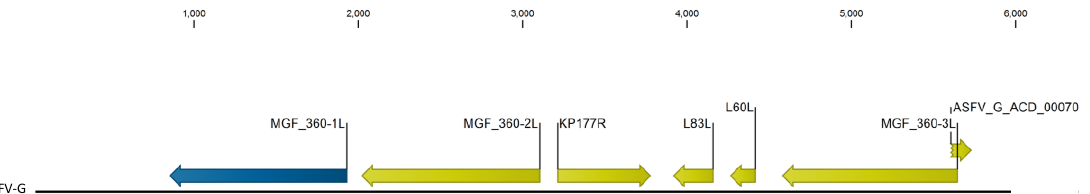
Figure 1. Schematic representation of the MGF360-1L ORF (blue) in the ASFV-G genome, showing adjacent open reading frames (yellow). ORF, open reading frame.